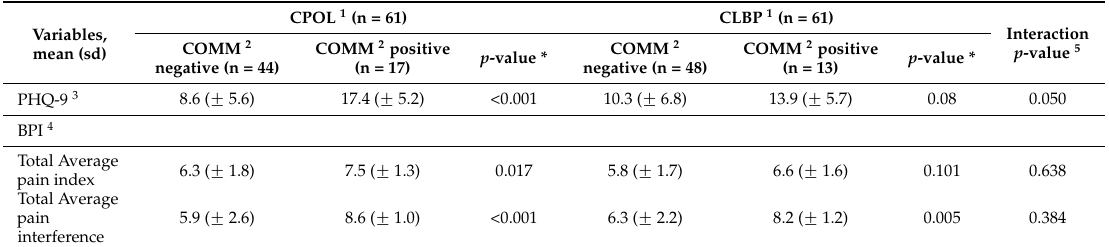
Table 3. Distribution of depression score and pain characteristics by opioid misuse, stratified by pain location (n = 122).